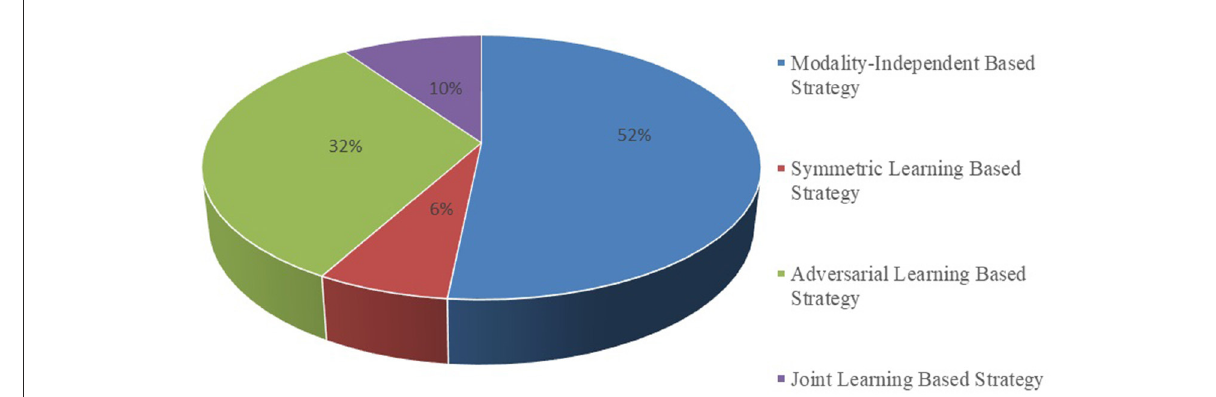
FIGURE4 Proportional distribution pie chart of the number of publications on different implementation strategies.